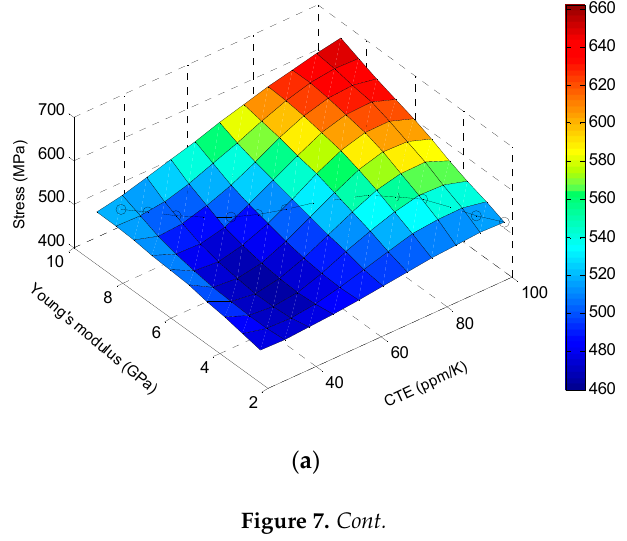
Figure 7. Cont. Figure 7.